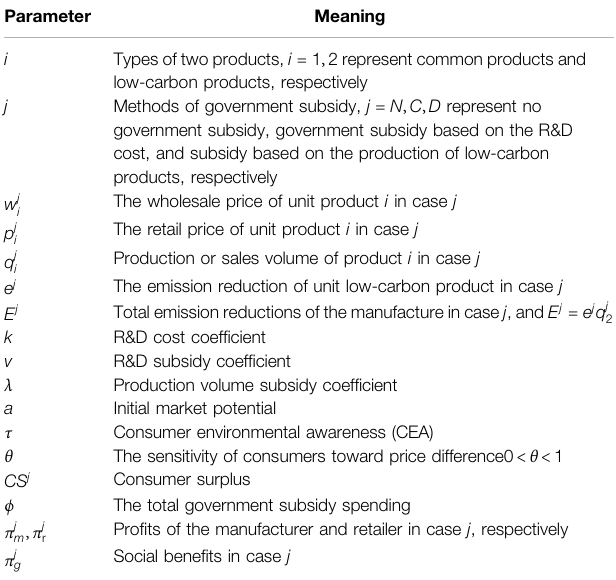
TABLE 1 | Parameter symbols and their meanings.